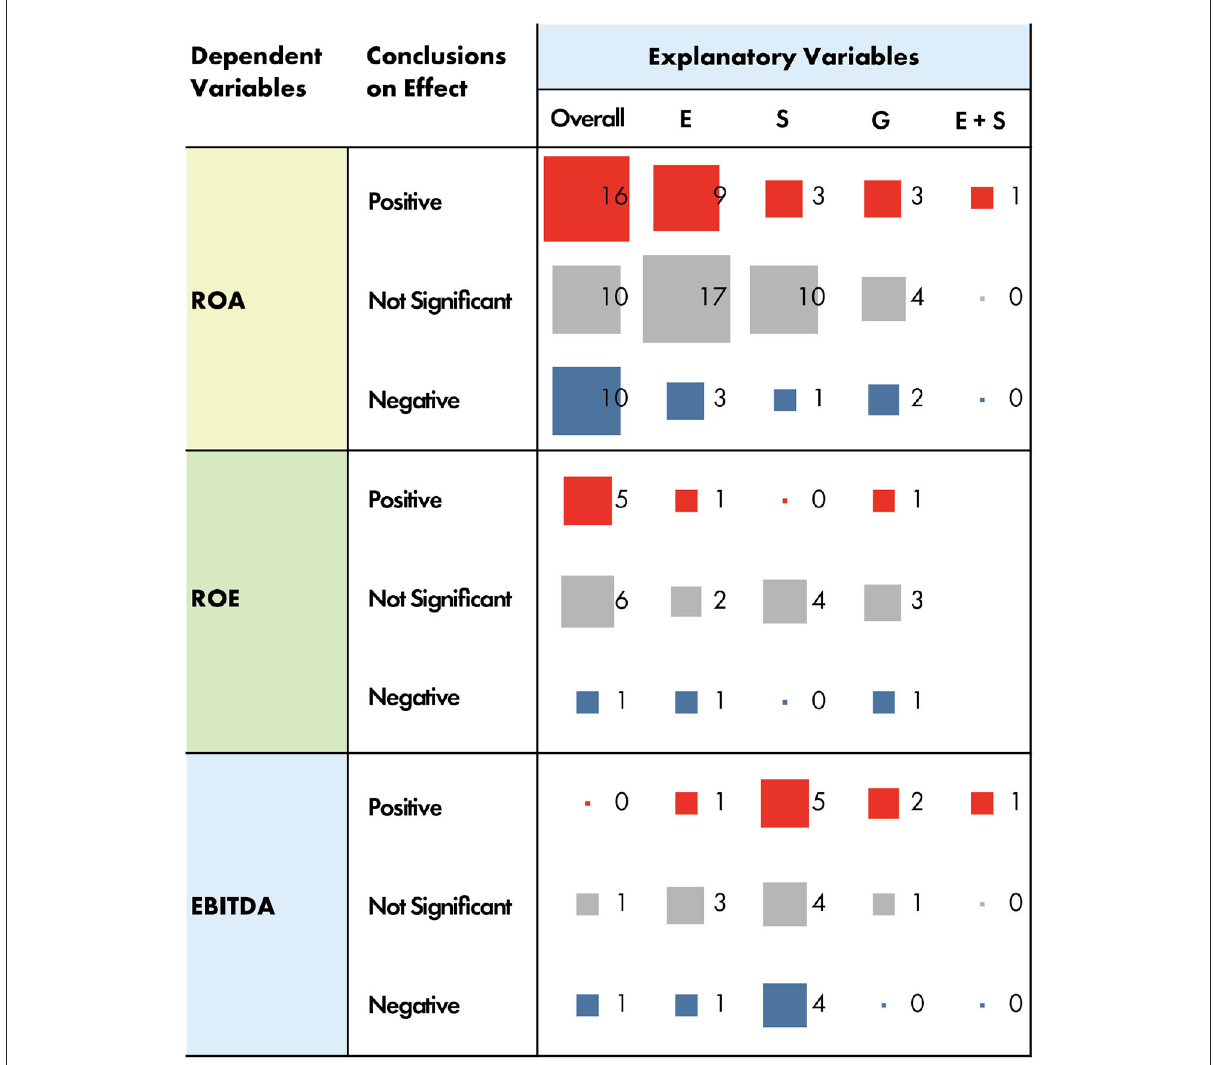
FIGURE5 Heatmap of the results of the studies with ROA, ROE, EBITDA as dependent